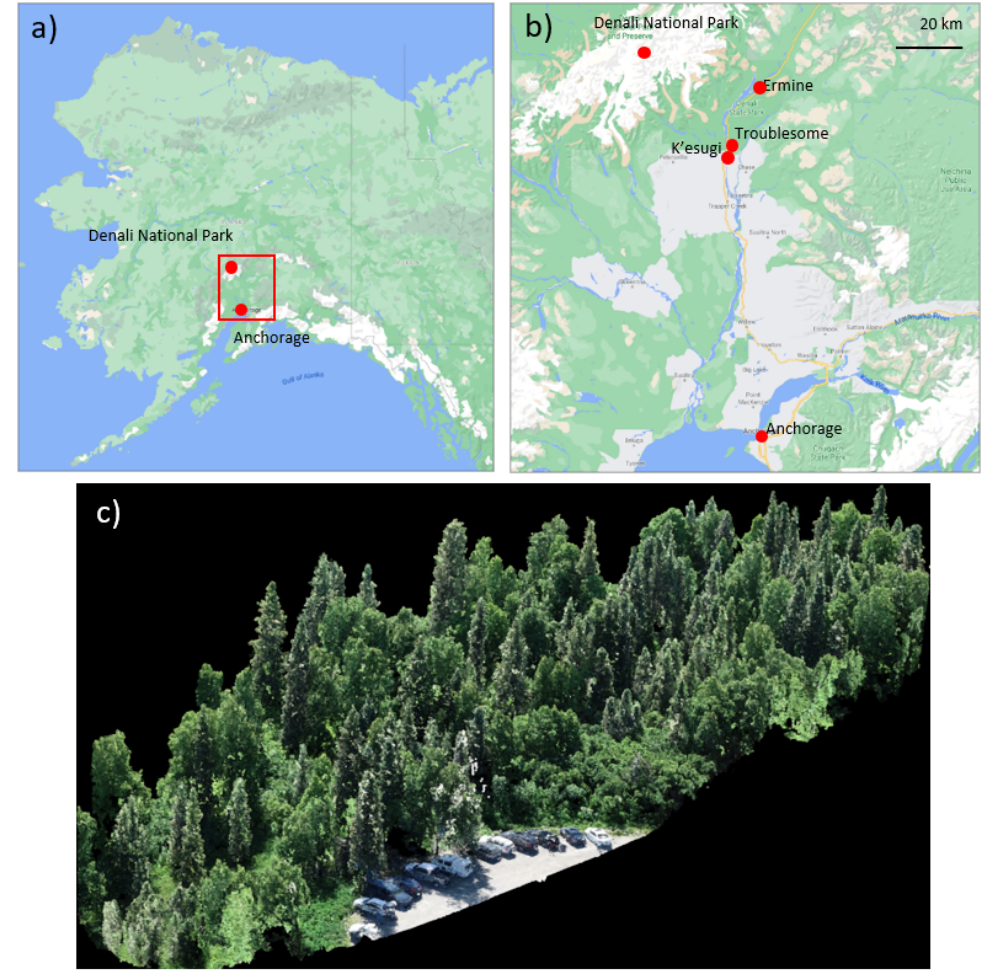
Figure 1. ( a ) Study area in Southcentral Alaska. ( b ) Zoom showing Ermine, Troublesome, and K’esugi study sites. ( c ) Data example: An RGB-colored point cloud from SfM (2 cm resolution) at Ermine.